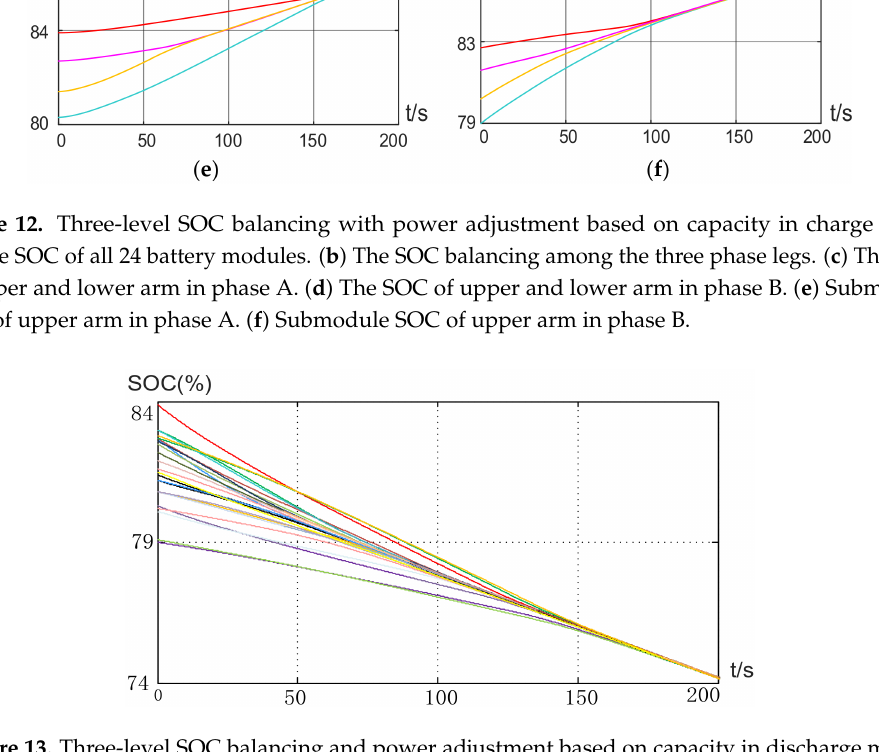
Figure 13. Three-level SOC balancing and power adjustment based on capacity in discharge mode.